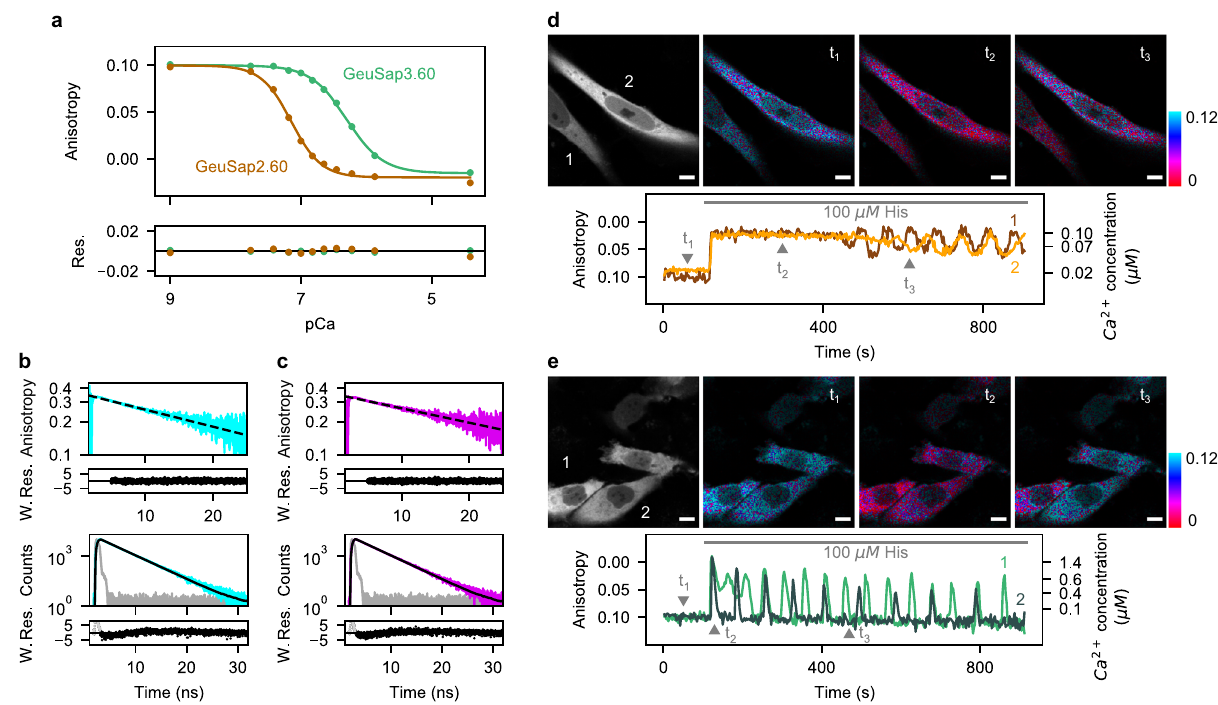
Fig. 5 Live cell Ca 2 + imaging by monitoring acceptor anisotropy. a Anisotropy Ca 2 + titration for GeuSapVC2.60 and GeuSapVC3.60 for calibration, fi tted with Hill function. Obtained fi tted values for GeuSapVC2.60 were n = 1.9 ± 0.2, K ’ d = 71 ± 3 nM, r max = 0.10 ± 0.00, r min = − 0.02 ± 0.00, and for GeuSapVC3.60 n = 1.6 ± 0.1, K ’ d = 502 ± 11 nM, r max = 0.10 ± 0.00, r min = − 0.02 ± 0.00. Residuals of the fi t are shown below the main plot. b Top: time- resolved anisotropy decay of GeuSapVC2.60 Ca 2 + -free form, excited at 485 nm. The decay was fi tted to a mono-exponential model after 5 ns (dashed line), which yielded θ = 28 ns. Bottom: Fluorescence lifetime decay of the same sample excited at 485 nm, fi tted to a mono-exponential model (black line). The fi tting yielded τ = 3.05 ns and χ 2 = 1.25. c Same plots as in b for GeuSapVC2.60 Ca 2 + -bound form. In this case θ = 33 ns and τ = 3.02 ns with χ 2 = 1.15. d Imaging of live HeLa cells expressing GeuSapVC2.60. Top: Stacked fl uorescence image of the fi rst 100 s (left), and anisotropy images displayed in IMD mode corresponding to timepoints indicated (right). Bottom: Time trace of fl uorescence anisotropy calculated from cells indicated on the left top panel. HeLa cells were stimulated with 100 μΜ histamine at t = 120 s. Right axis indicates Ca 2 + concentrations calibrated with the titration curve shown in a . Signal-to-noise ratio for parallel and perpendicular channel was calculated as 17 ± 2 and 14 ± 2, respectively (Supplementary Fig. 7b and c). e Imaging of cells expressing GeuSapVC3.60, similar as in d . Scale bar represents 10 µ m. For panels d and e , imaging of transfected cells was repeated at least 10 times, yielding basically the same results. Res.: residuals; W. Res.: weighted residuals. Source data are provided as a Source Data fi